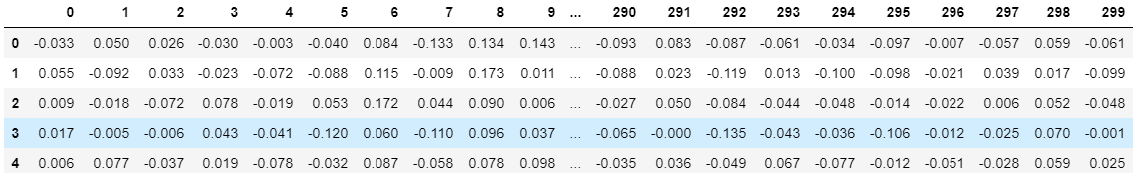
Figure 6. Vector representation of text.